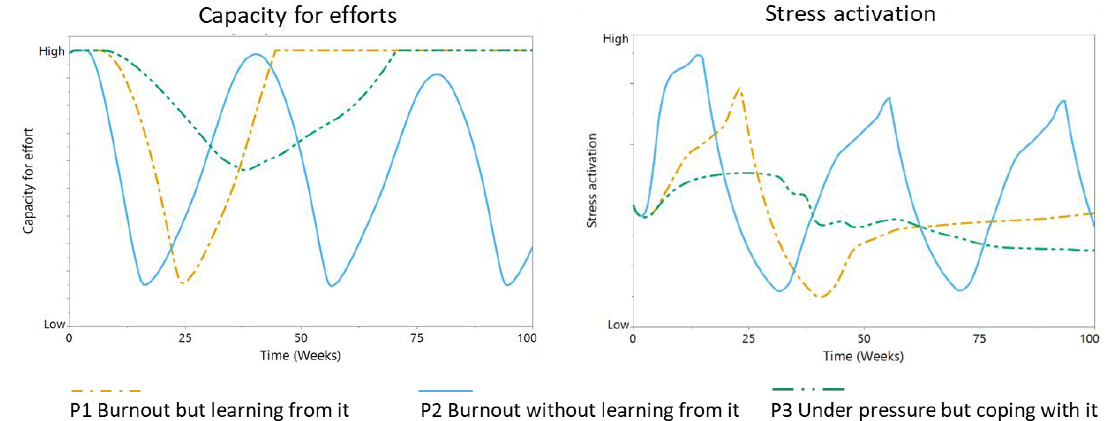
Figure 8. Model behavior patterns for “cognitive and emotional functions” and “self-e ffi cacy”, parameterized for the simulations of di ff erent personas (P): ”P1 “burnout but learning from it” (orange Figure 8 . Model behavior patterns for 'Cognitive and emotional functions' and 'Self efficacy', parameterized for the simulations of personas (P). P1 'Burnout but dotted line), P2 “burnout without learning from it” (blue line), and P3 “under pressure but coping with learning from it' (orange dotted line), P2 'Burnout without learning from it' (blue line) and P3 'under pressure but coping with it' (green dotted line). Simulated with it” (green dotted line). VENSIM PLE© v7.0